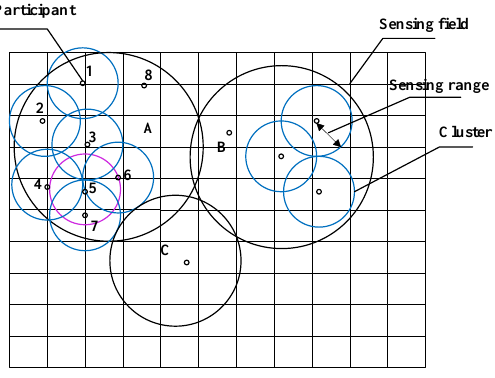
Figure 1. Active participants in a clustered MCS.